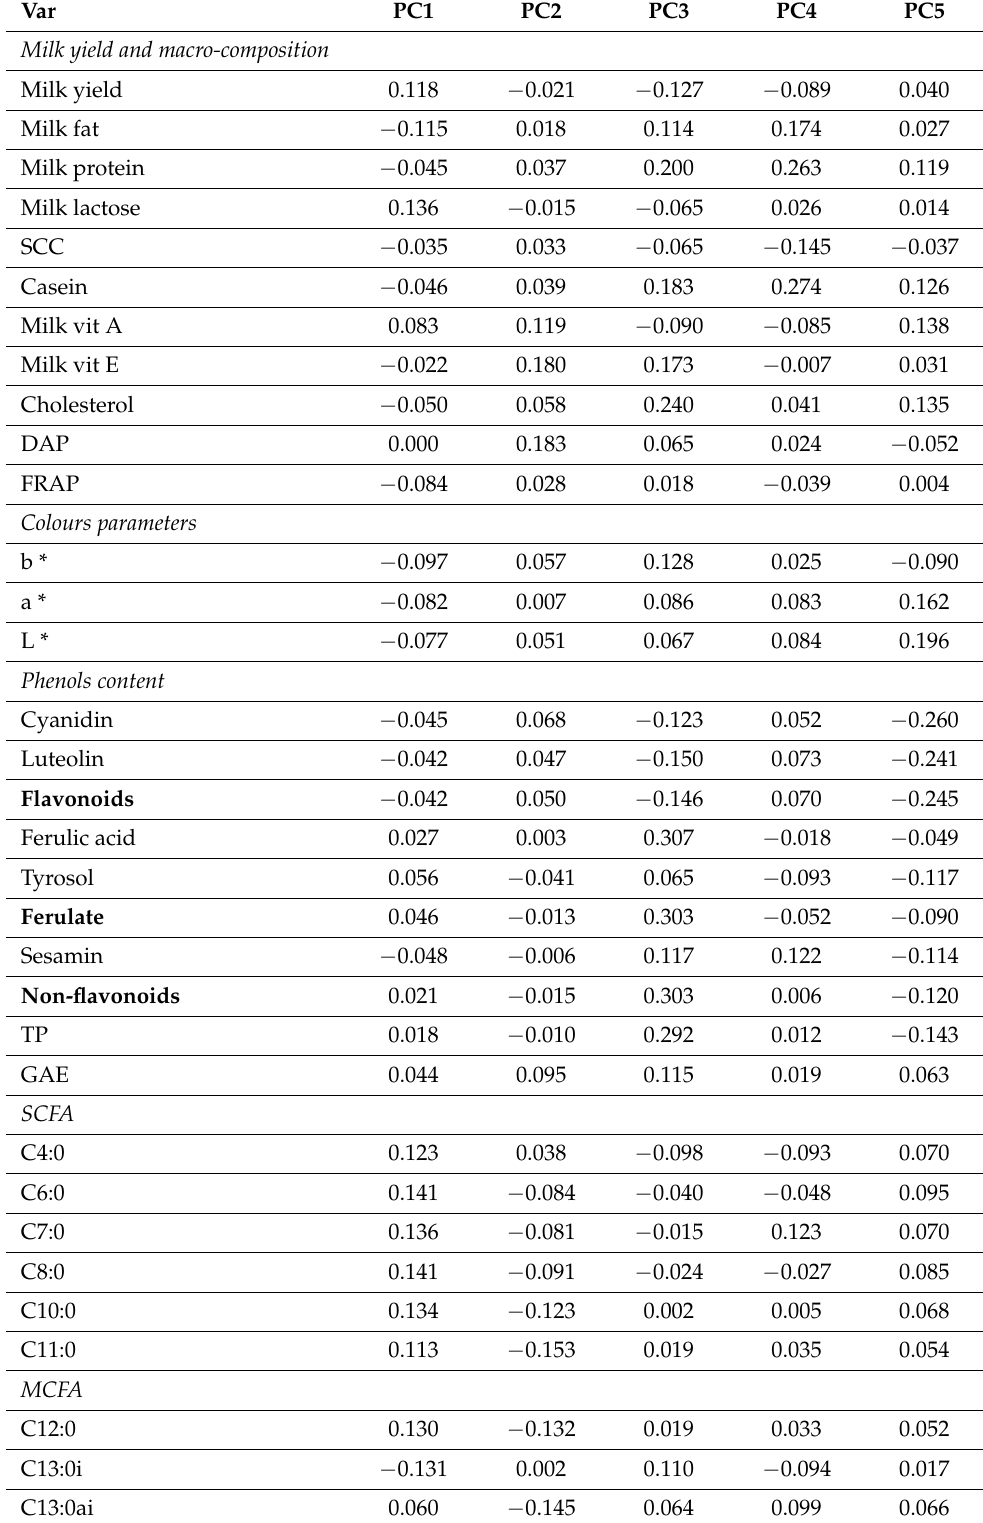
Table 2. Eingenvectors, eigenvalues, and percentage of variance explained of the first five principal components (PC) extracted from the correlation